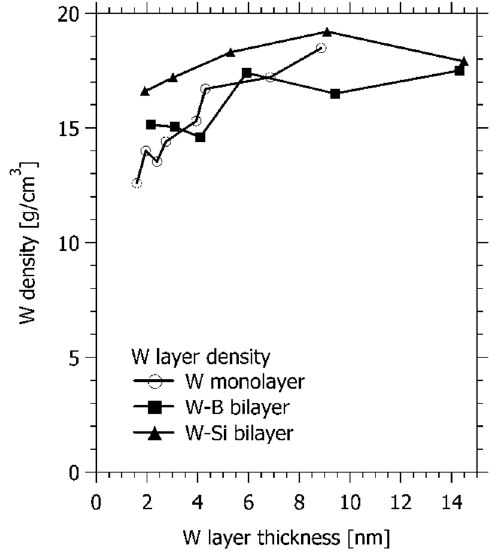
Figure 7. Tungsten-layer density vs. layer thickness for W–B and W–Si bilayers.